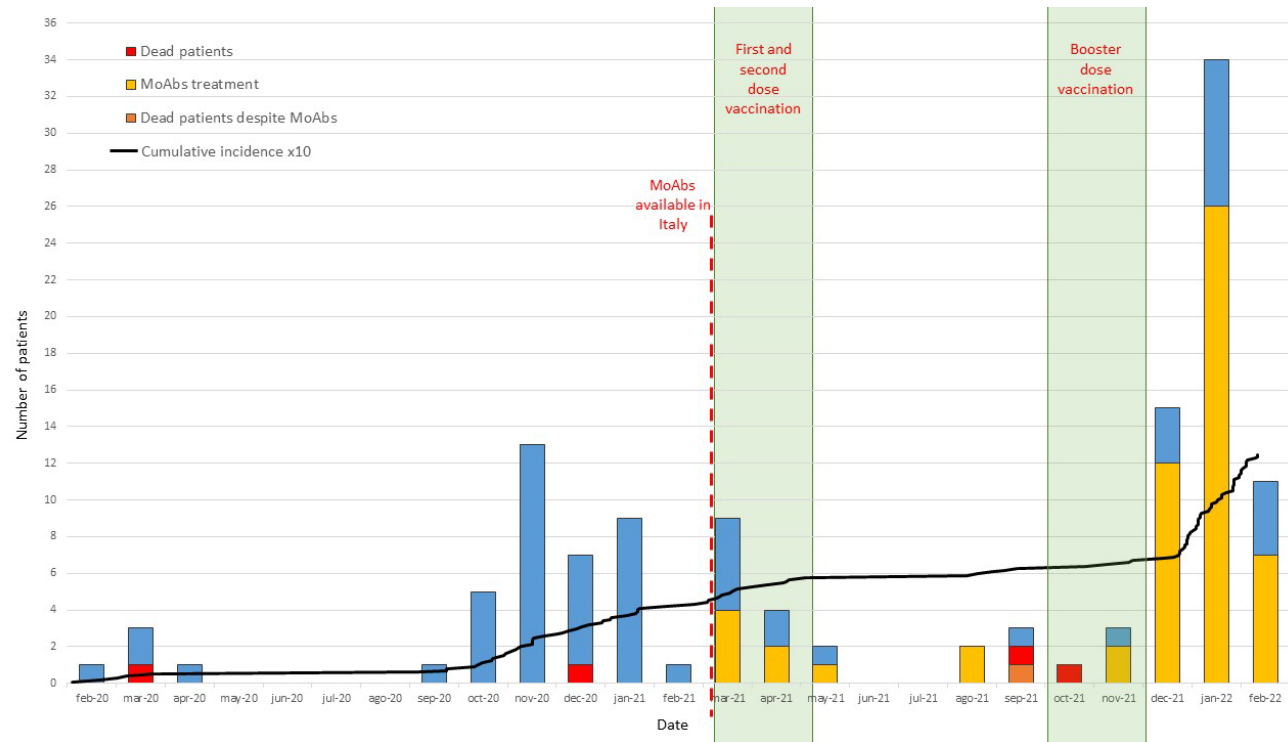
Figure 1. Number of SARS-CoV-2-infected patients in the cohort of IEI patients with antibody deficiencies in the first twenty-four months of the pandemic. In blue, patients who recovered; in yellow, patients treated with MoAbs and recovered; in orange, patients who died despite MoAbs; in red, patients who died. Cumulative incidence is indicated by a black line, and initial date of MoAbs availability in Italy is indicated by a red dotted line. The two periods of first/second doses of vaccine administration, and of booster dose administration are indicated by a shadowed area.